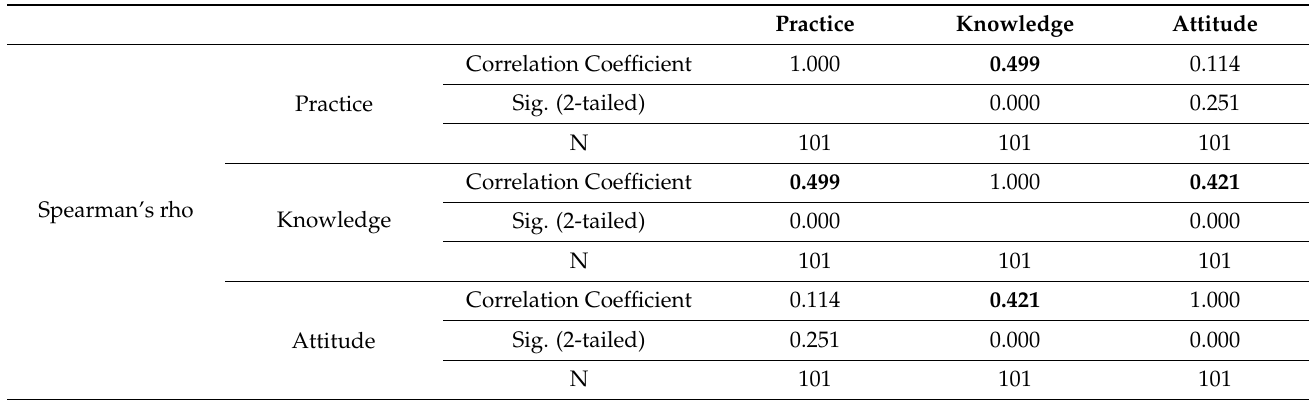
Table 7. Spearman’s correlation test